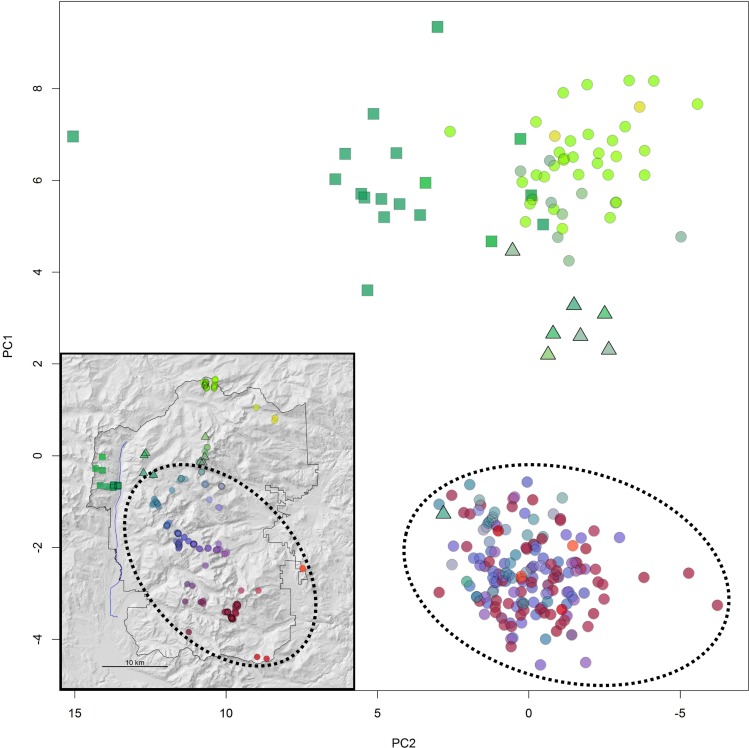
Principal component analysis of individual pika microsatellite genotypes.Points are color-coded according to geographic location and correspond to sampling locations in inset map of ROMO. Triangles represent individuals identified from the STRUCTURE analysis as having notably mixed ancestry (0.2 ≤ Q < 0.8). Points in the dashed oval correspond to sampling localities within the dashed oval in the inset map, which in turn correspond to red points in Fig 4. These points separate along PC1 and are geographically isolated by topography. The sampling localities west of the Colorado River (dark green squares west of blue line in inset) partially separate along PC2.